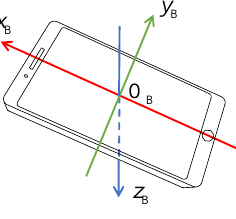
Figure 3. Definition of the sensor body